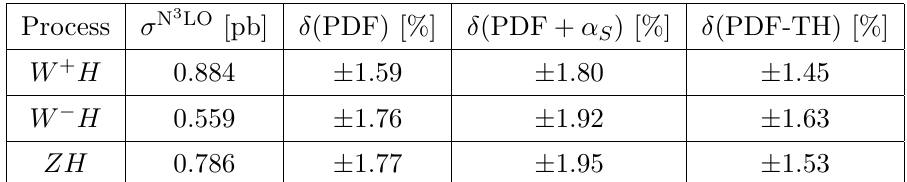
Table 3 . Total cross section for associated Higgs production at N 3 LO in QCD, at a 13 TeV pp collider for a dynamical central scale choice µ used. The symmetrical PDF, PDF+ α